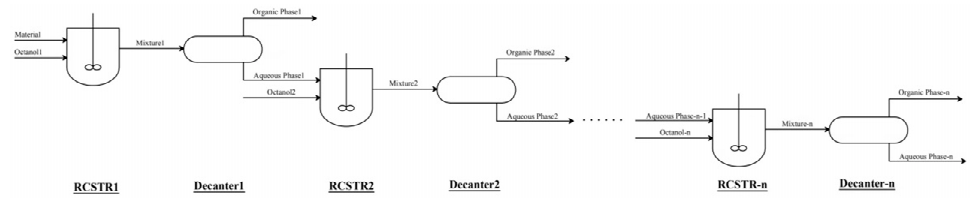
Figure 12. Multi-stage crosscurrent reaction extraction simulation flow chart.